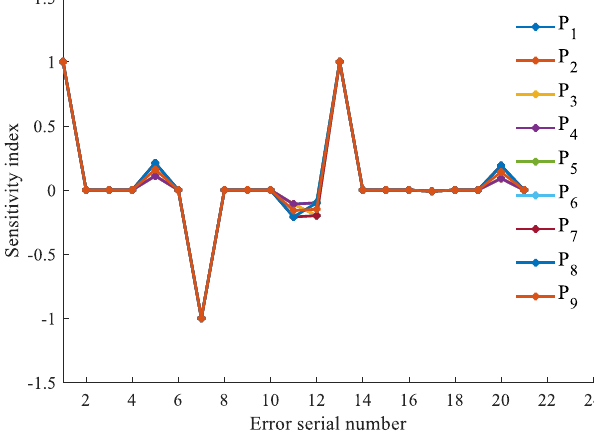
Figure 3. Sensitivity index of position errors in the x direction.